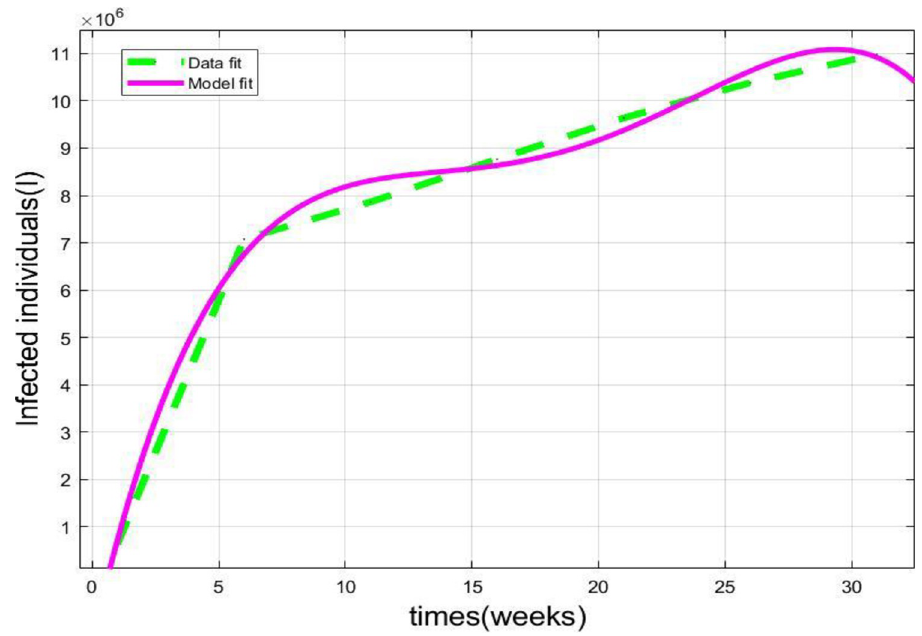
Fig 6. Graph of the infected class of the proposed model (3.3) and real infected data [Table 4].